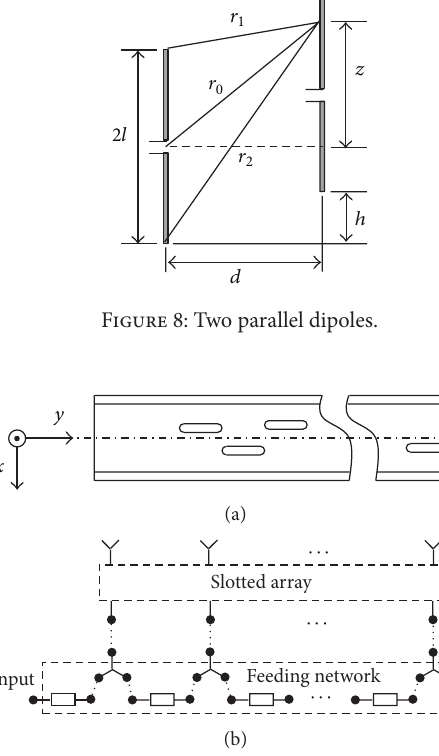
Figure 9: The resonant array. (a) Configuration. (b) Equivalent